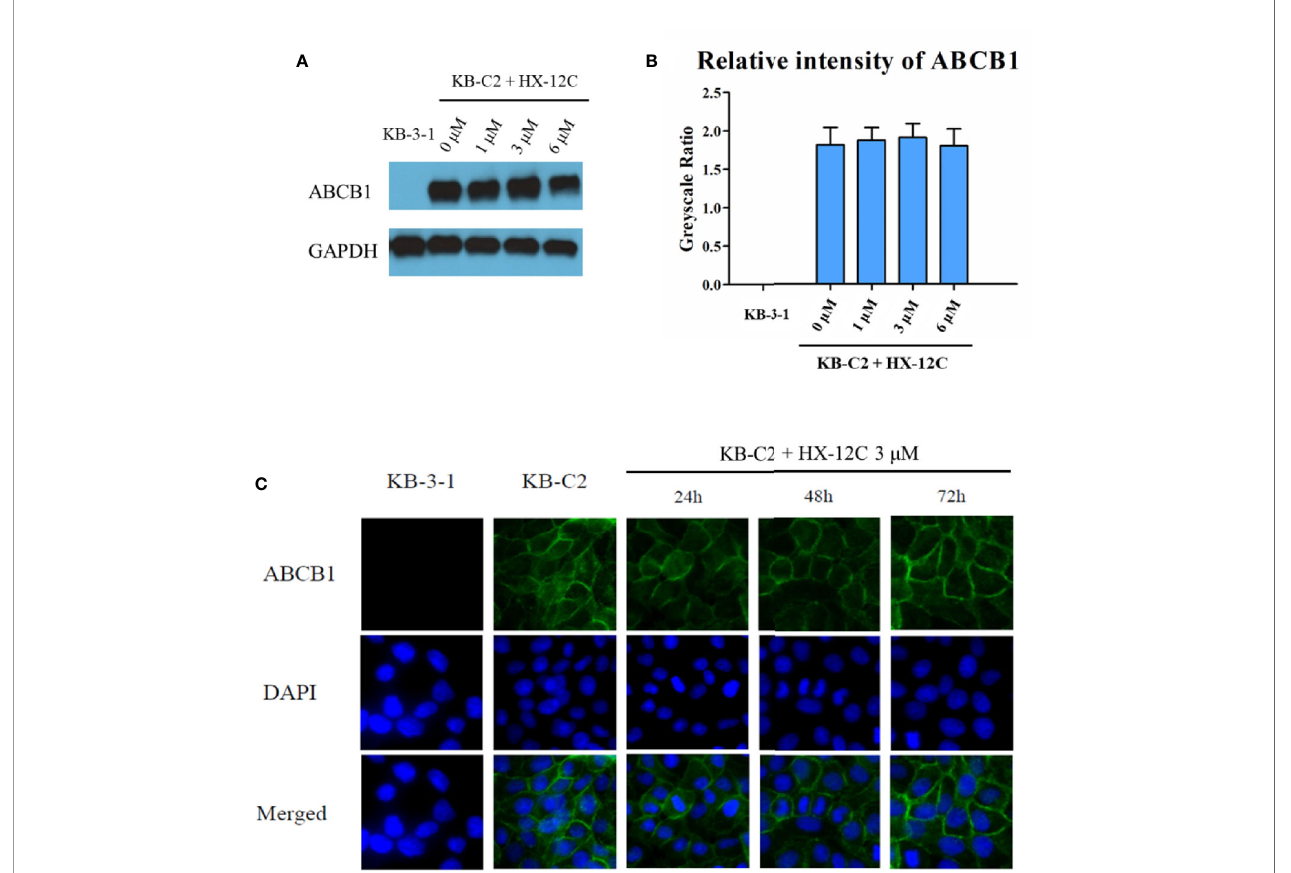
FIGURE 3 | The effect of peptide HX-12C on the expression level and subcellular localization of ABCB1 protein in KB-3-1 and KB-C2 cells. (A) The expression of ABCB1 protein after incubation with different concentrations of peptide HX-12C for 72 h in KB-C2 cells. KB-3-1 cells without any treatment used as the negative control of ABCB1 protein expression. GAPDH was used as loading control. (B) The relative intensity of the expression of ABCB1 to the expression of GAPDH. Expression level quanti fi cation by gray scale values calculated by ImageJ software. (C) The expression of ABCB1 protein after incubation with 3 m M peptide HX-12C for 0, 24, 48, and 72 h. DAPI was used to counterstain the nuclei to locate the cells. Pictures have been modi fi ed by Photoshop software for merged comparison.